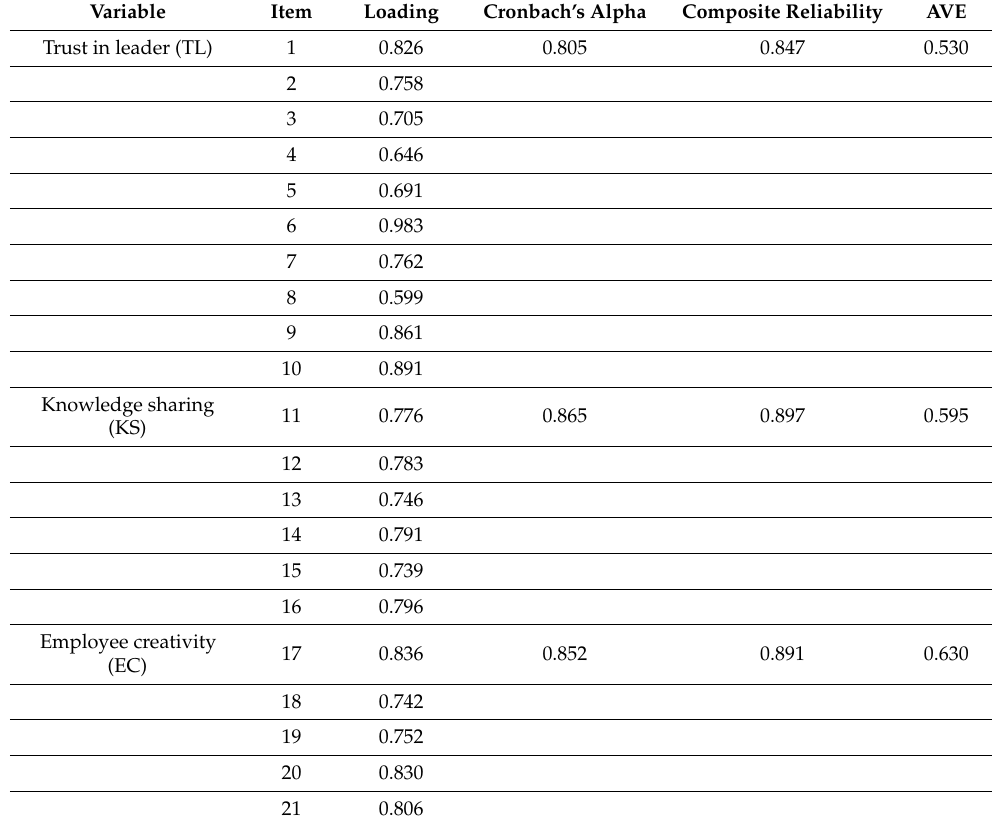
Table 3. Item loadings, Cronbach alphas, composite reliabilities, and average variances extracted